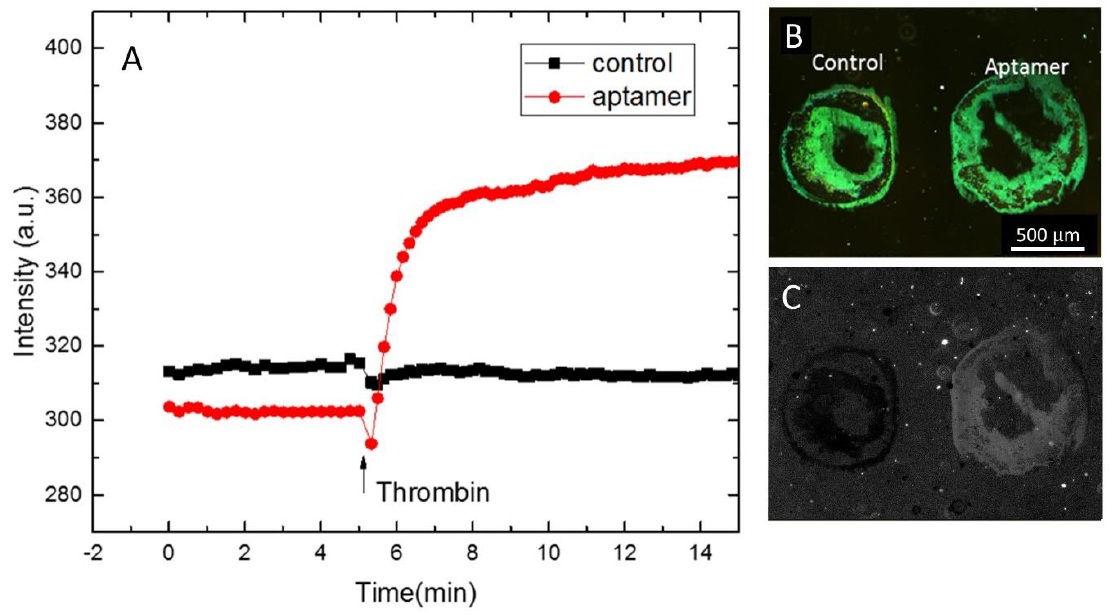
Figure 6. Detection of thrombin from optimized aptamer functionalized gratings. The lipid composition was DOPC:DOTAP 40:60, pixels with a maximum green/red ratio were chosen, and gratings were fabricated to have maximum heights as determined by the relative fluorescence intensity. ( A ). Sensorgram showing a change in diffraction from the aptamer functionalized gratings upon exposure to thrombin. ( B ) Initial diffraction intensity of lipid gratings printed onto PMMA. ( C ) Processed image after exposure to thrombin for 10 min. The green channel after exposure was divided by the green channel before exposure to show the change in diffraction intensity.